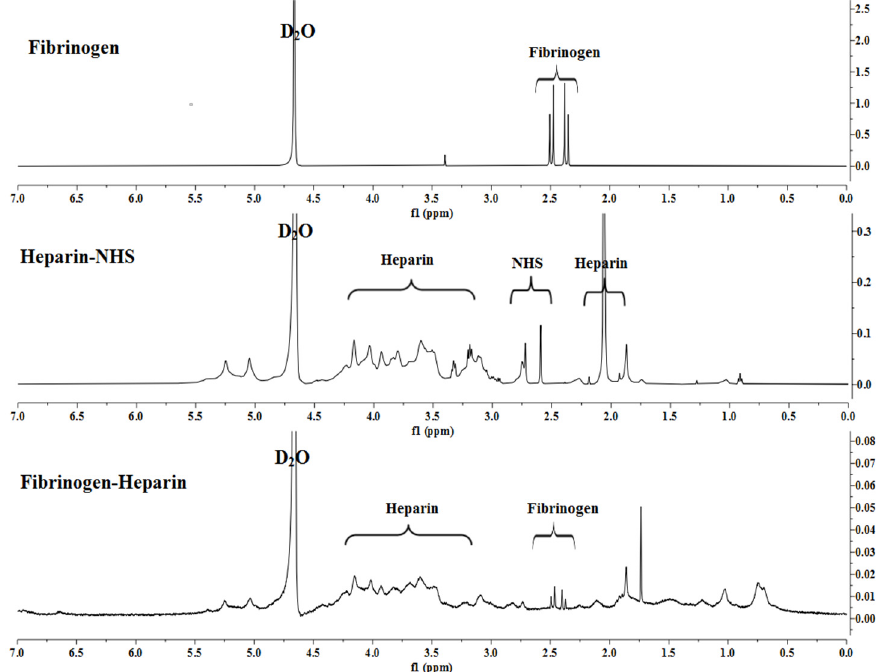
Figure 1. 1 H-NMR spectra of fibrinogen, heparin and heparin-conjugated fibrinogen.